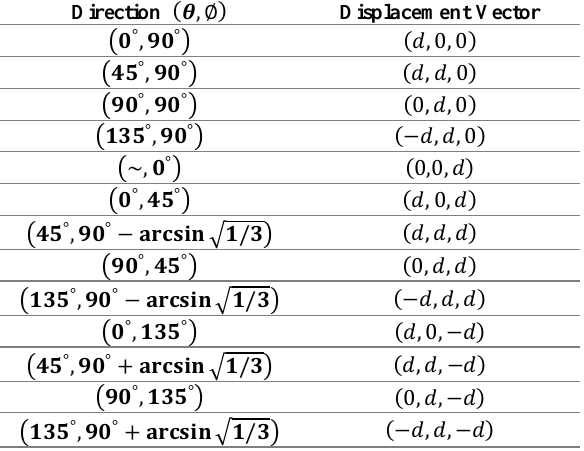
Table 2. Displacement Vectors for GLCM for Volumetric